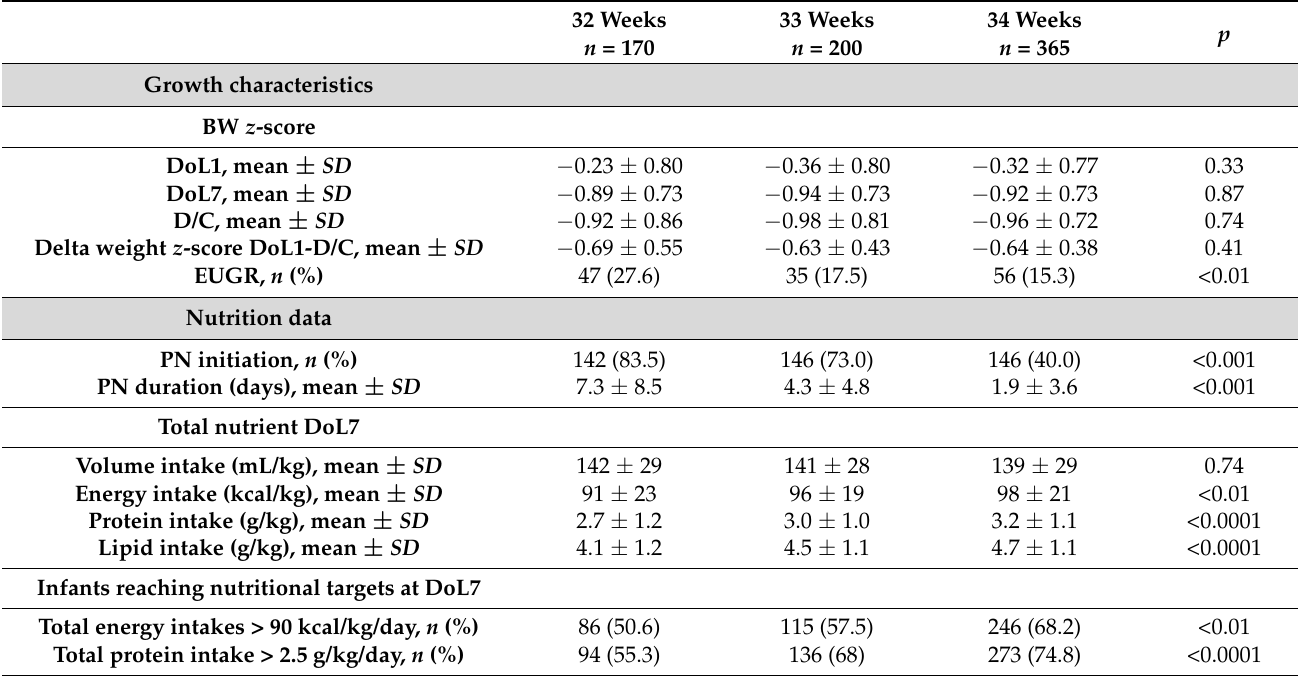
Table 3. Nutrients and growth during the first week according to gestational